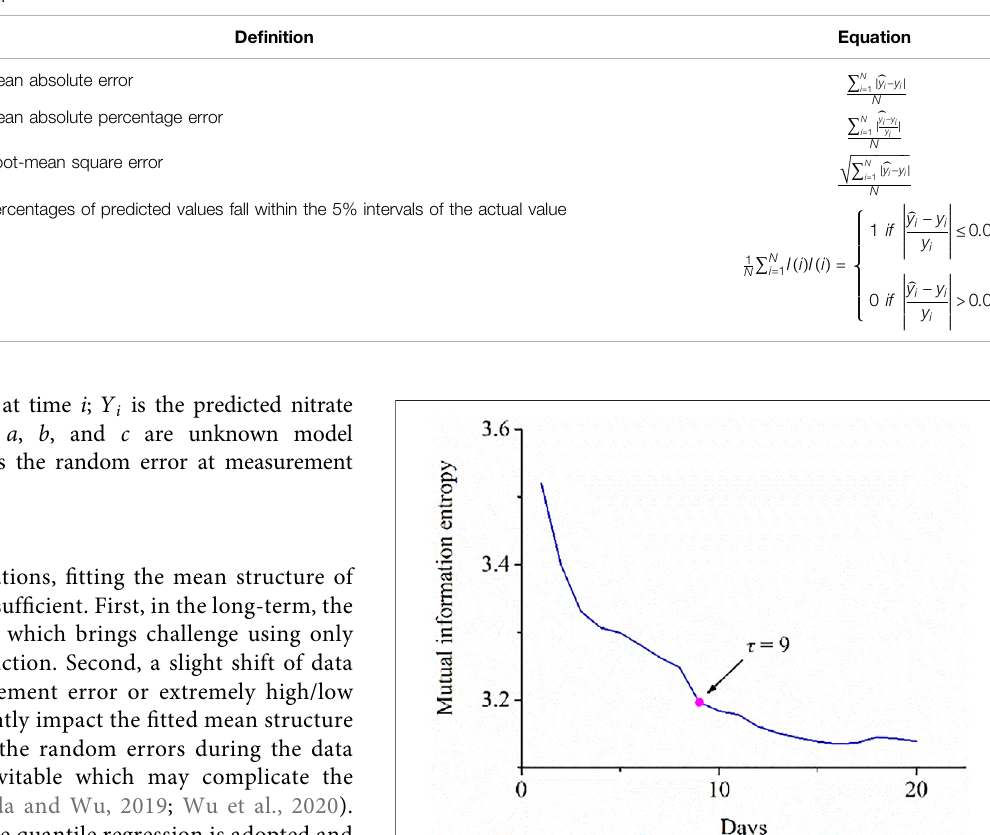
TABLE 2 | Measurement metrices.